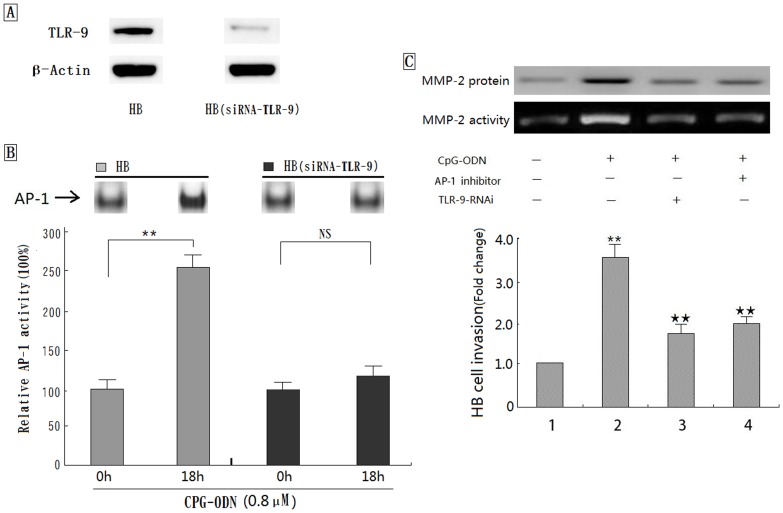
Role of MMP-2 in TLR-9/AP-1 mediated cancer cell invasion.(A) Expression of TLR-9 protein in HB cells before and after 48 hr of transfection. β-actin was used as an internal control. (B) CpG-ODN treatment does not enhance AP-1 activity in HB cells transfected with special siRNA against TLR-9. (**P<0.01, NS: no significant) (C) The interferon effect of AP-1 inhibitor and/or TLR-9-RNAi on the CpG-ODN induced MMP-2 expression/activity as well as subsequent cancer cell invasion. (**P<0.01, compared with the panel 1), (★★P<0.01, compared with the panel 2)